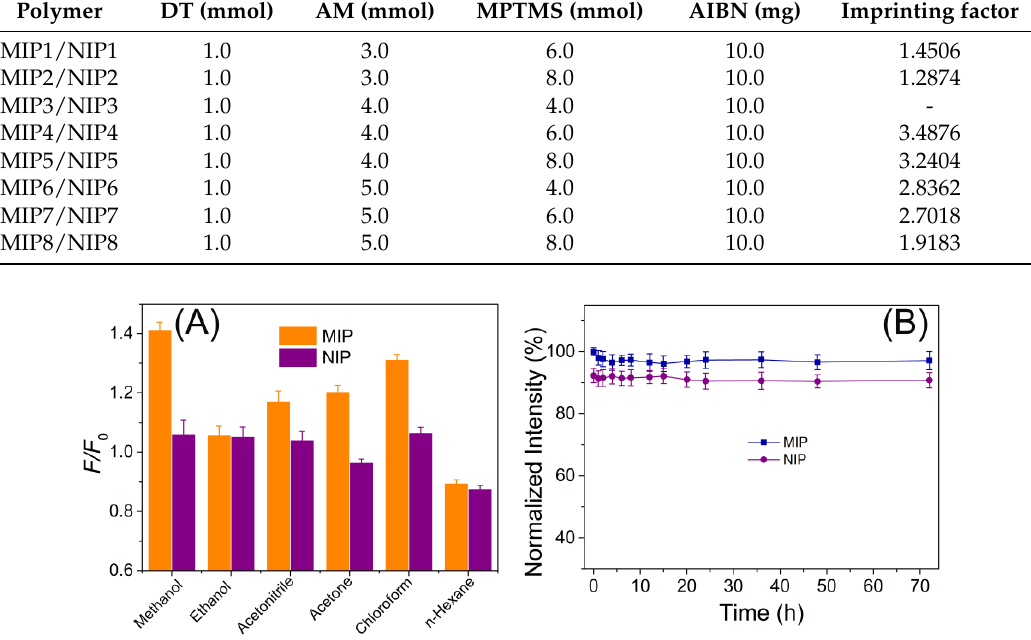
Figure 4. ( A ) The effect of adsorption media on the specific recognition performance of MIP and NIP; ( B ) The fluorescence stability of the MIP and NIP materials. Table 1. The optimization of template/monomer/cross-linker ratios for the polymerization.